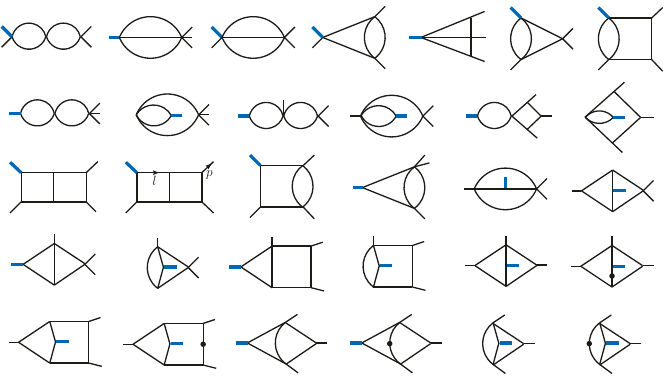
Figure 8 . The full set of master integrals of the two-loop 3-point form factor. The line with a dot represents a double